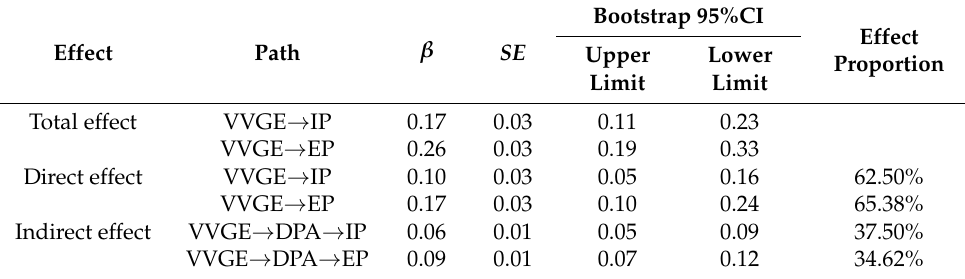
Table 4. Breakdown table of the total effect, direct effect, and mediating effect.